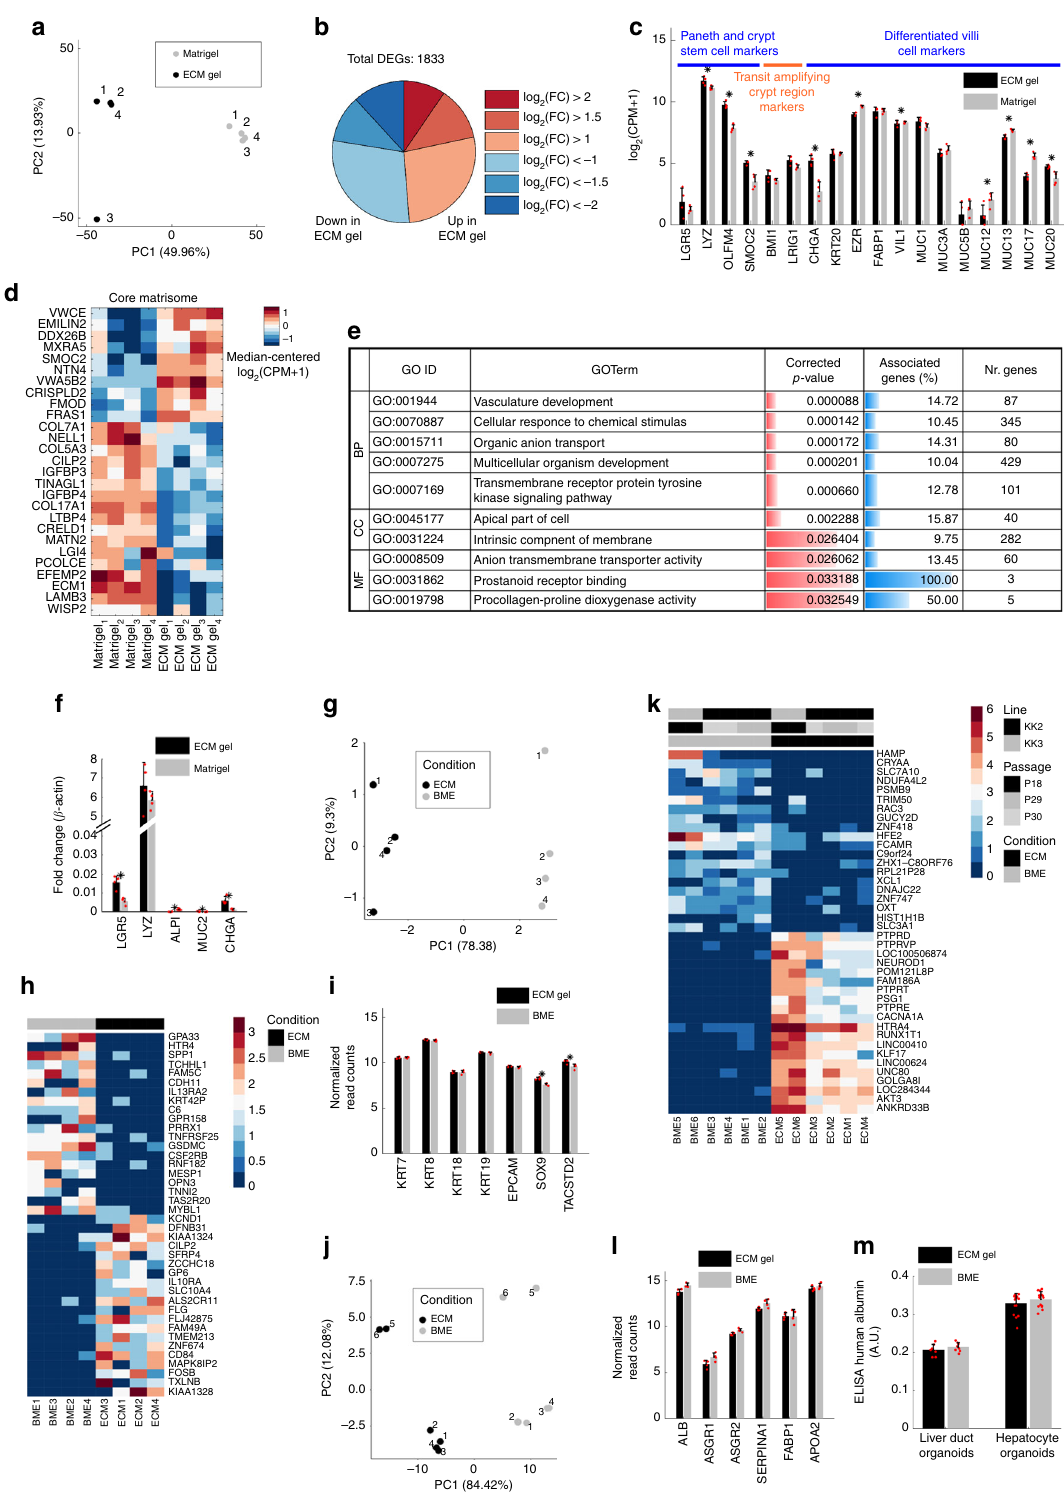
TACSTD2 (TROP2) were signi fi cantly upregulated in the ECM gel culture condition (Fig. 4i). Both are markers of progenitor-like cells, where TROP2 has been recently described as a marker of bipotent progenitors 30 . The cluster map of human ductal liver organoids cultured in ECM gel vs. BME is shown in Supplementary Fig 7c. The RNA-seq analysis for the human fetal hepatocyte organoids highlighted also in this case a distance between